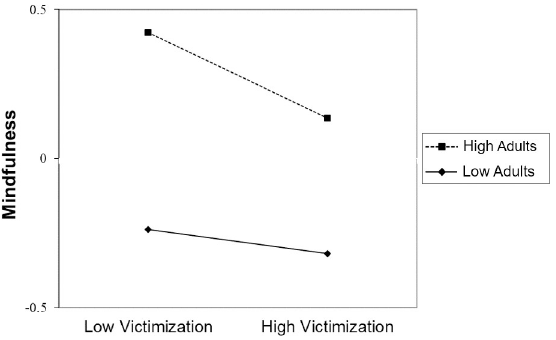
Fig 1. Modeled mindfulness in 7 th grade as a function of victimization and connectedness with adults at home in 7 th grade ( N = 4,584). Adults = connectedness with adults at home.